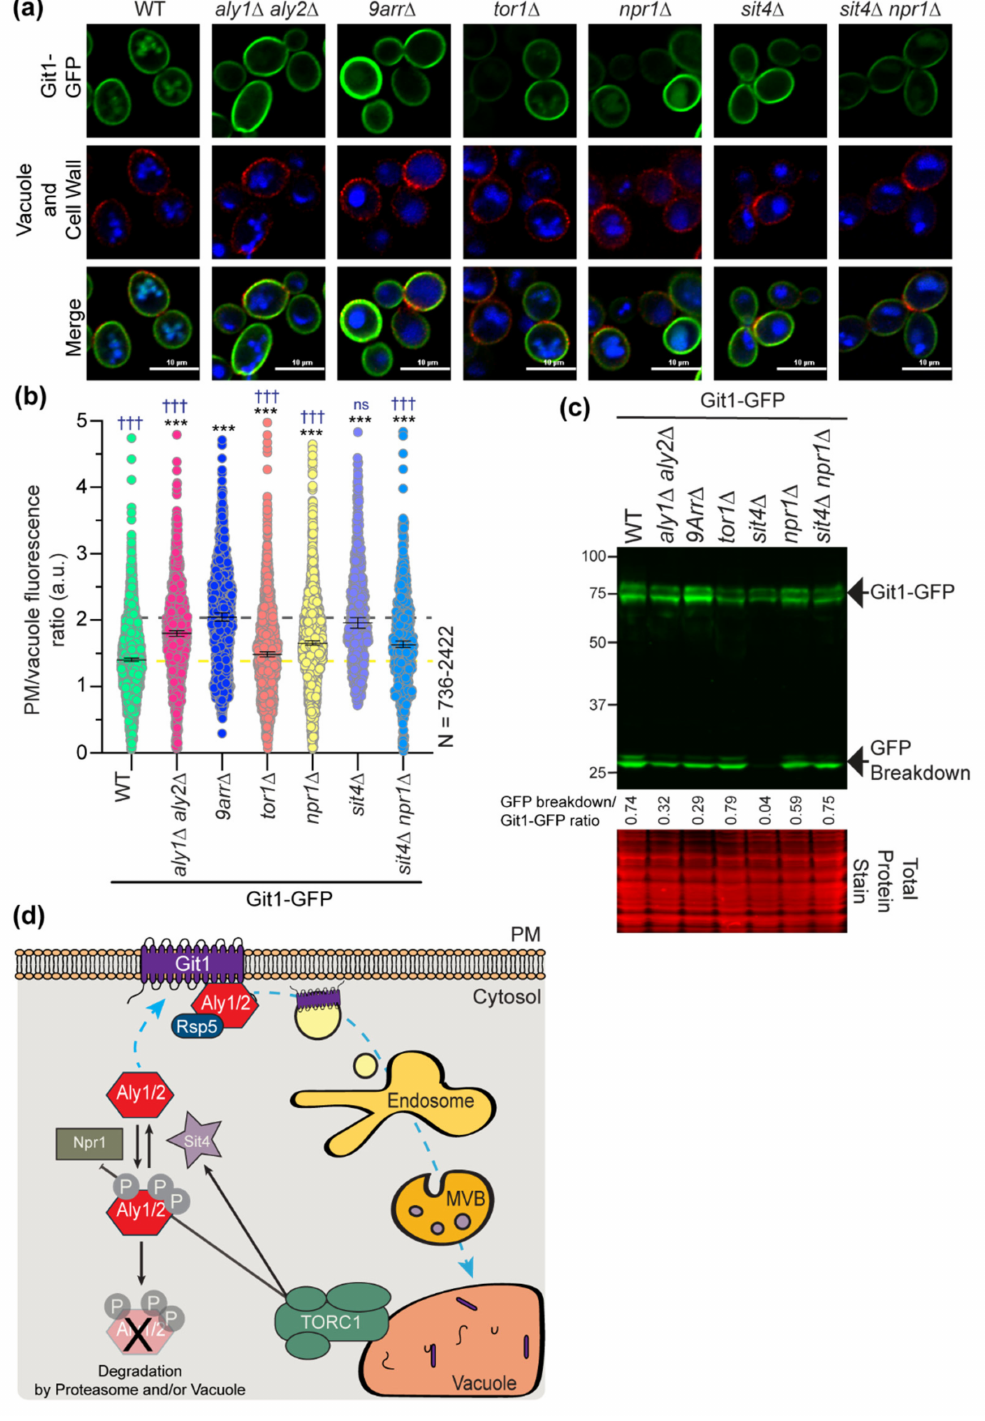
Figure 10. TORC1-Sit4-Npr1 regulation of Aly-mediated trafficking of Git1: ( a ) Git1-GFP was expressed from the TEF1pr in either WT cells or those lacking the gene indicated and imaged by